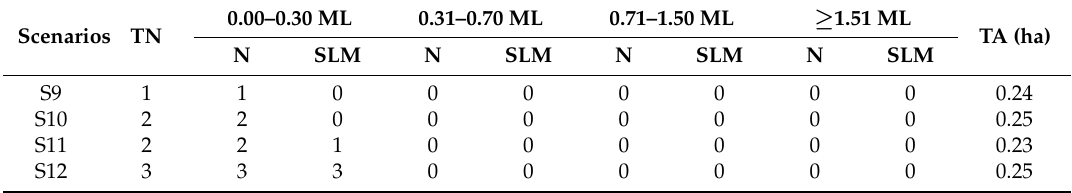
Table 6. TN, N, SLM, and TA of Scenarios S9–S12 for the convention